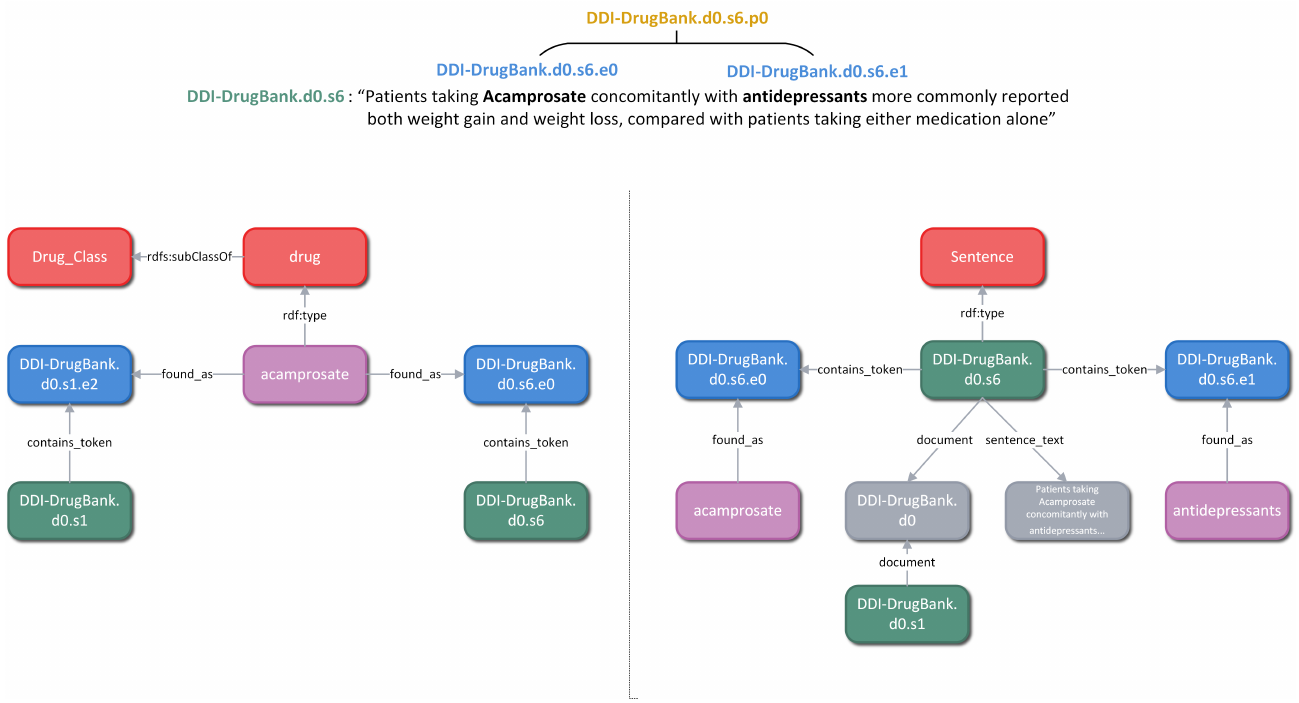
Figure 2. The DDI Knowledge Graph overview based on an example sentence. ( Left ) drug sub-graph; ( Right ) sentence sub-graph.